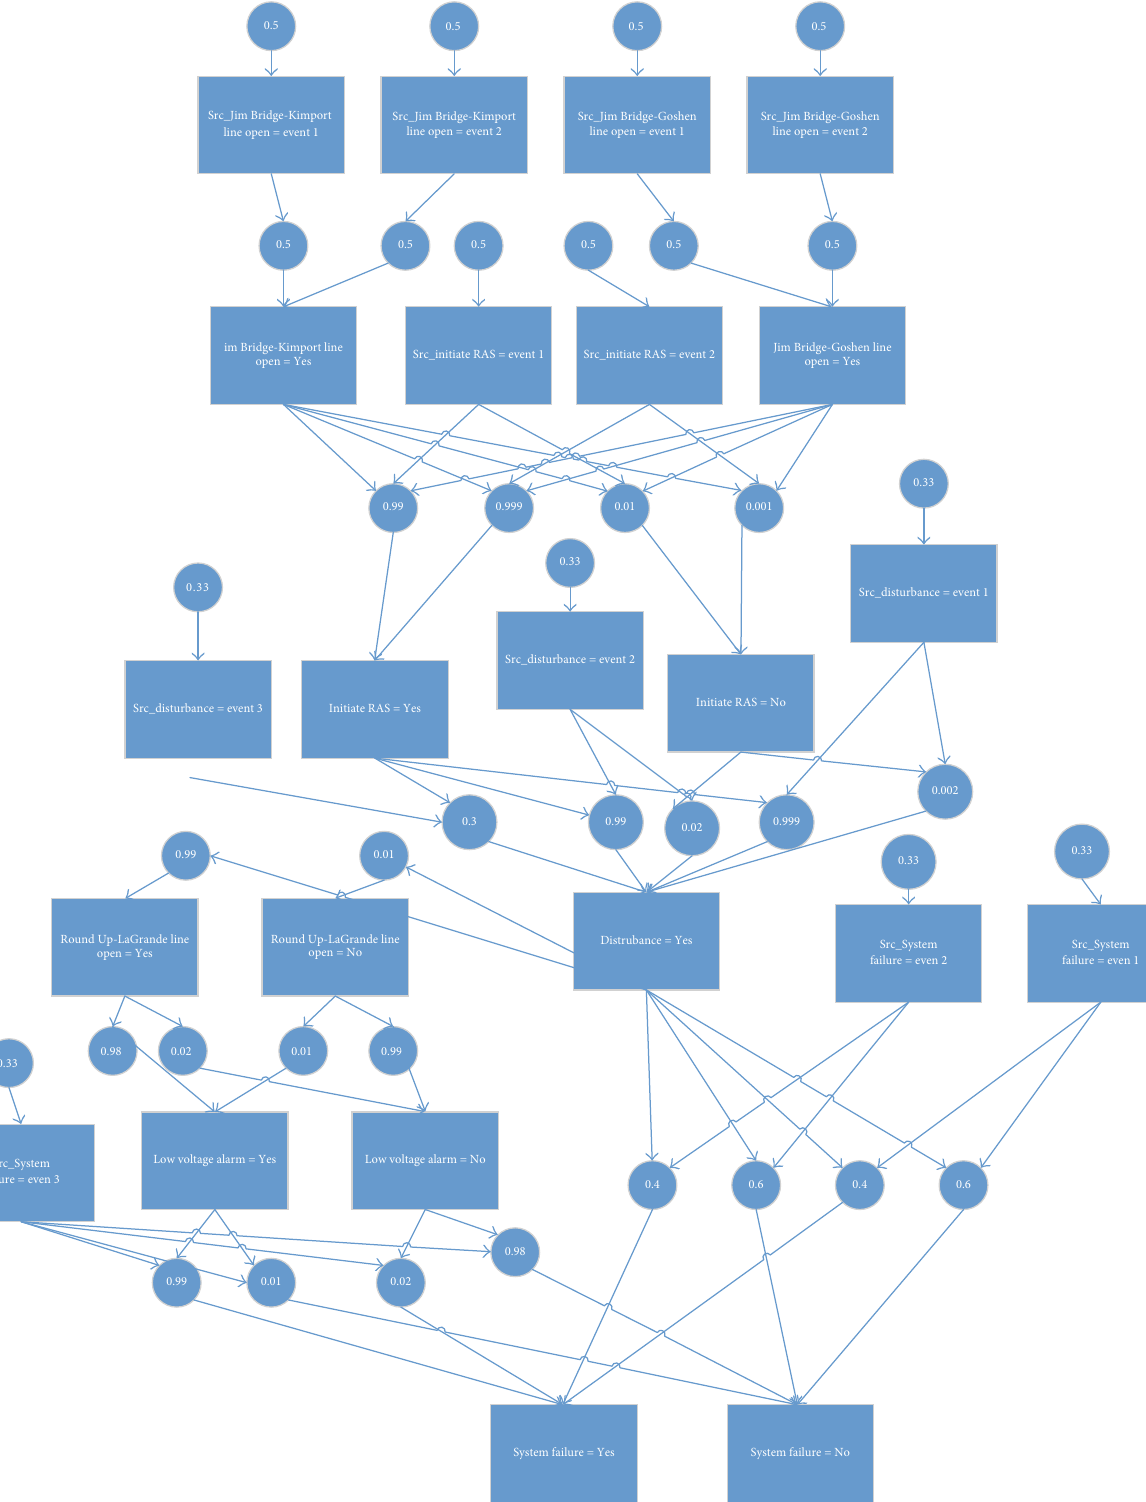
Figure 5: Three-event fused BKB with equal